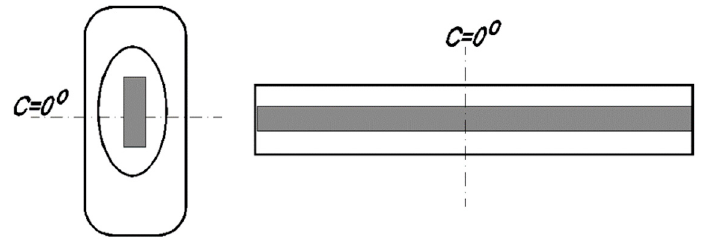
Figure 3. According to the traditional understanding, the position of the C0 plane depends on the shape of the luminaire dimension and should be perpendicular to the longitudinal axis of the lumi-